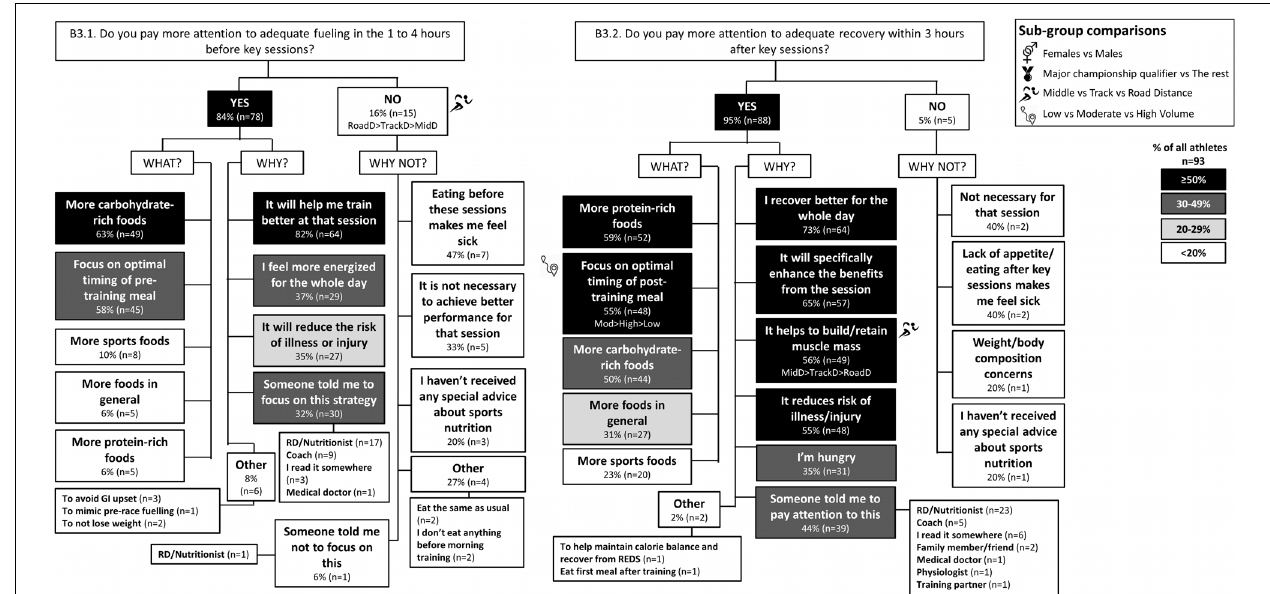
FIGURE 4 | B3: Nutrition before (3.1) and after (3.2) key training sessions during base training phase. The prevalence of specific nutrition practices around fueling and recovery from key training sessions and the reasons for following them in 93 elite female and male track and field endurance athletes. Please see full description for figure within Figure 1